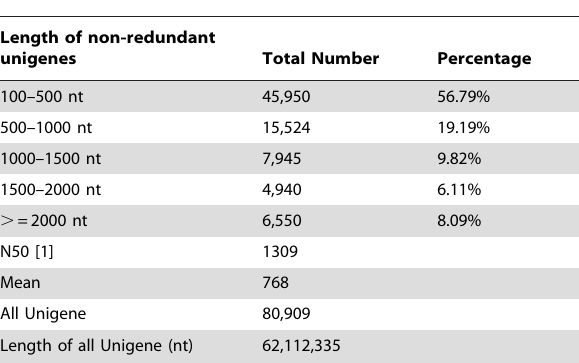
Figure 2. Images of wood anatomy of TW, OW and NW. Environmental scanning electron microphotographs of the transverse surface of tension wood (A–D) and opposite wood (E–H) in stems (LS) of birch cultivated for 8 wks under control conditions (I–L). A, E, I: 6 300; B, F, J: 6 500; C, G, K: 6 1000; D, H, L: 6 3000. Scale bars are described in O. V, vessel; F, fibre; GF, G-layer fibre. M and N show the unusual growth of different parts of birch stems subjected to bending for 8 wks. doi:10.1371/journal.pone.0087566.g002 Table 1. Length distribution of all